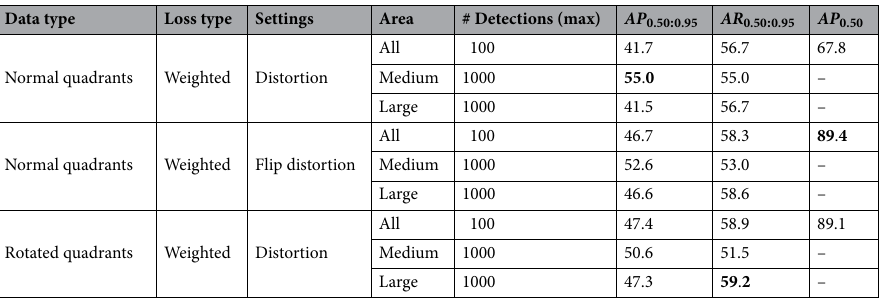
Table 3. Object detection metrics of the enumeration detection task on the test quadrant dataset. AP 0.50 : 0.95 : Average precision of bounding boxes that have an IoU between 50% and 95%. AR 0.50 : 0.95 : Average recall of bounding boxes that have an IoU between 50% and 95%. All scores are written as a percentage. The highest scores are highlighted in bold.